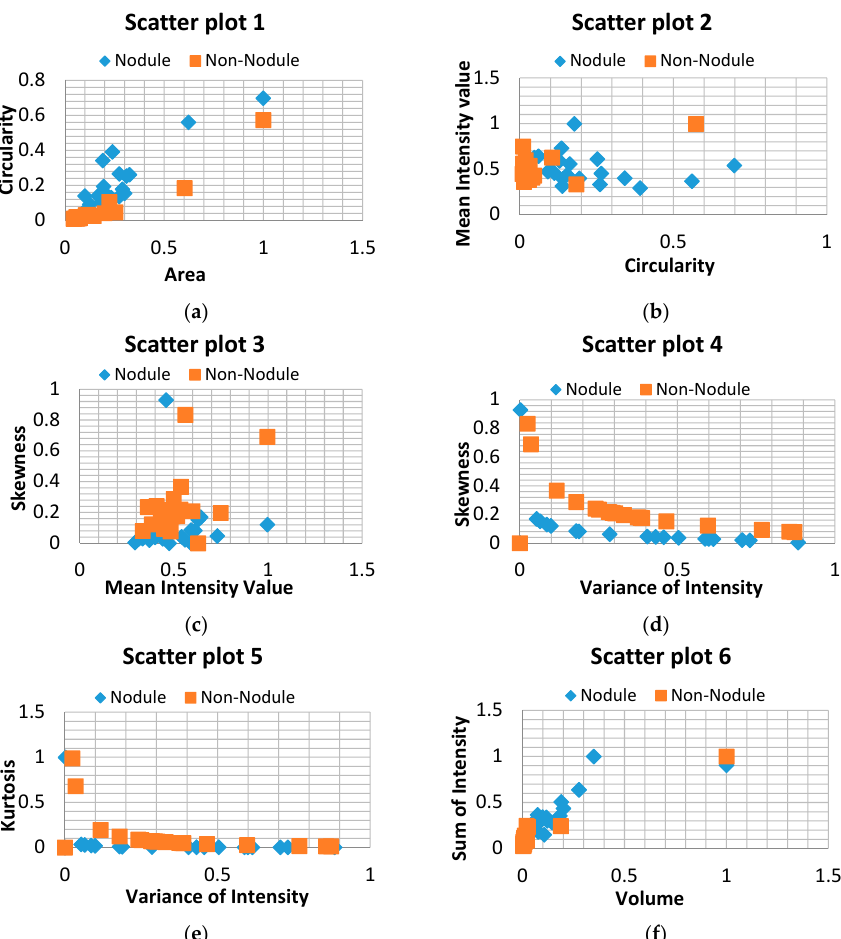
Figure 6. Scatter plots showing the relationship of features between ( a ) Area and Circularity; ( b ) Circularity and Mean intensity value; ( c ) Mean intensity value and Skewness; ( d ) Variance of Intensity and Skewness; ( e ) Variance of intensity and Kurtosis; ( f ) Volume and Sum of Intensity. Table 1. Selected